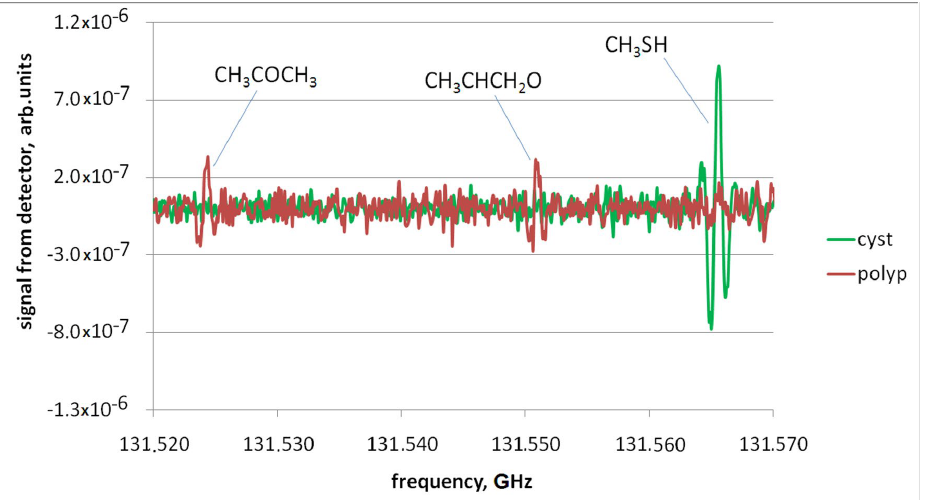
Figure 6. Record of the spectrum section containing absorption lines of methyl mercaptane (CH3SH) (f 1exp = 131.5656 GHz, f 1cat = 131.56548 GHz) for cyst sample (green curve), acetone (CH3COCH3) (f 2exp = 131.5244 GHz, f 1cat = 131.52444 GHz), and propylene oxide (CH3CHCH2O) (f 3exp = 131.5508 GHz, f 3cat = 131.55101 GHz) for polyp (red curve), where f iexp are experimentally measured central frequencies and f icat are frequencies from spectroscopy databases [11,12].